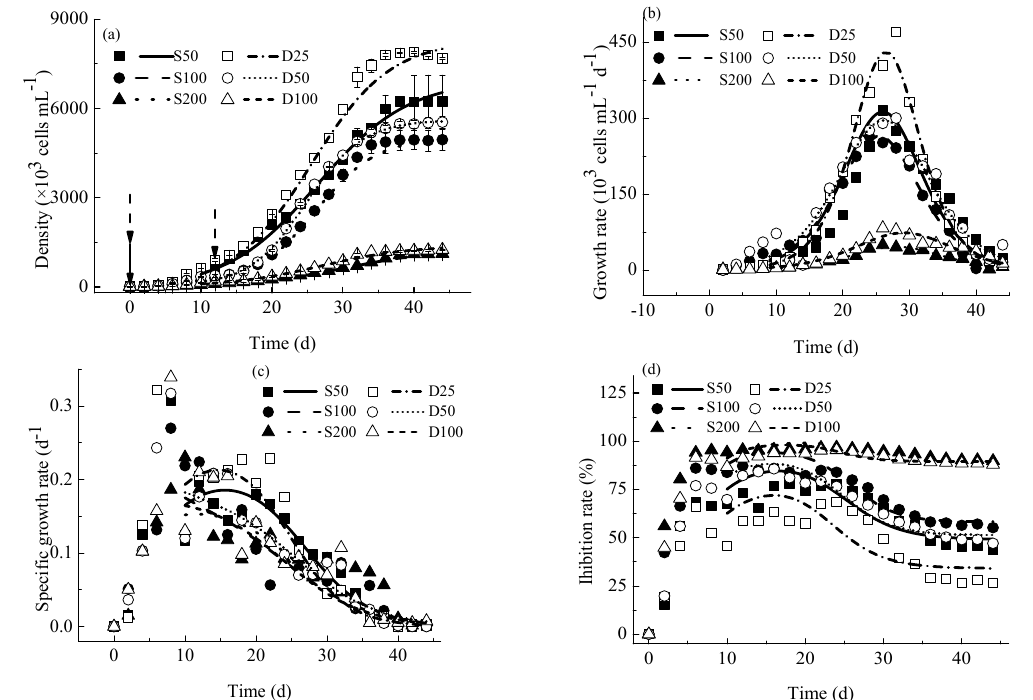
Figure 1. Variations of M. aeruginosa densities ( a ), growth rates ( b ), specific growth rates ( c ), and inhibition rates ( d ) with time. Dots-measured values, lines-fitted values. Solid arrow-the time at which prometryn single exposure carried out, dotted arrows-the time at which prometryn double exposures carried out.